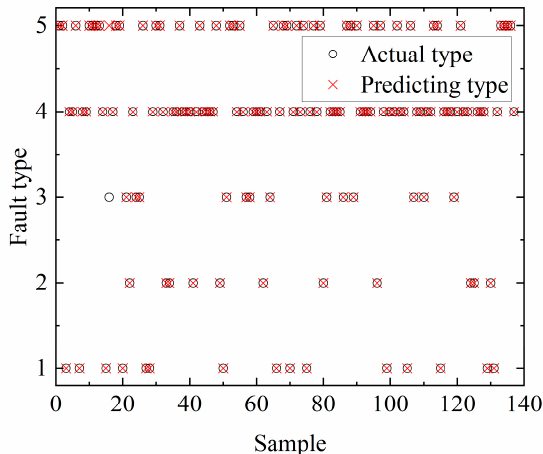
Figure 10. Test results of the DBN classification test set.